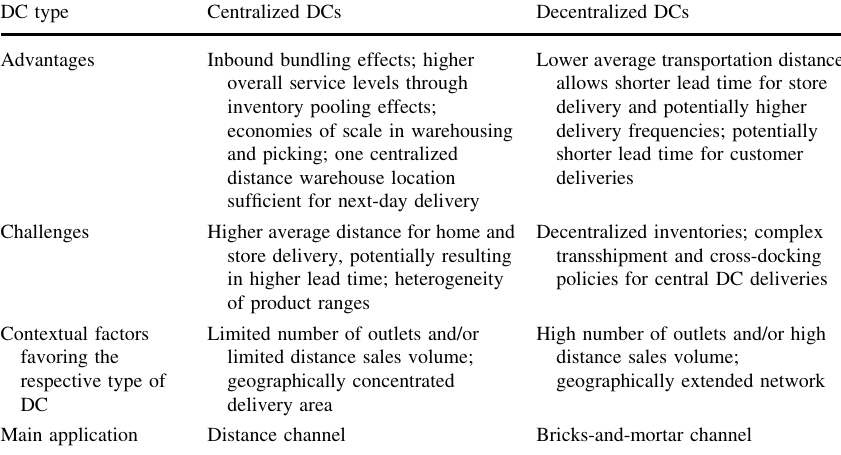
Table 2 Summary of centralization of omni-channel retailer DCs DC